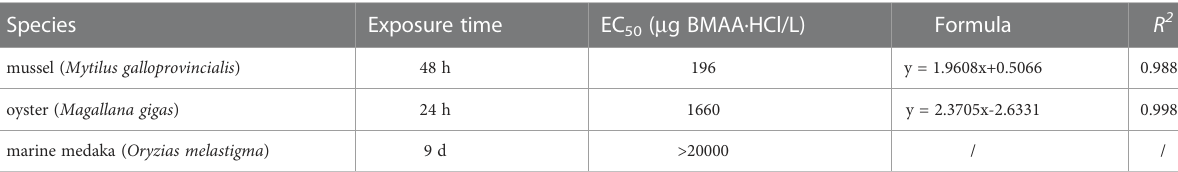
TABLE 1 The EC 50 values calculated by the malformation ratios of different embryos exposed to BMAA.